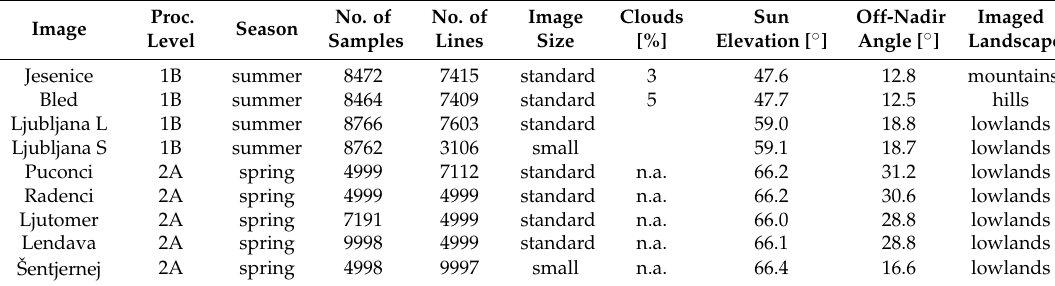
Table 2. Selected characteristics and metadata parameters for nine WorldView-2 level 1B and 2A images. The variability of the available WorldView-2 images is smaller than that of RapidEye images. Images are referenced by location